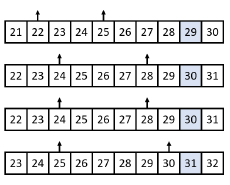
Figure 2: S 4 i +1